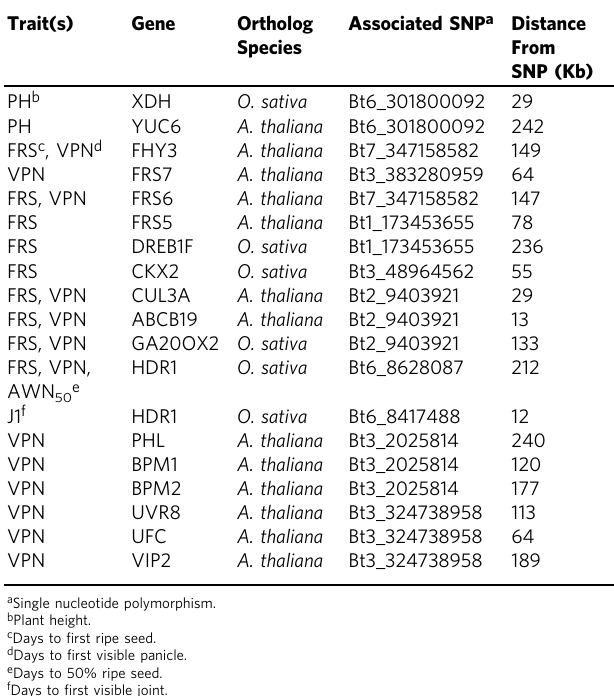
Table 3 Candidate genes within 250 kbp of SNP identi fi ed by GWAS, with two ortholog species Arabidopsis thaliana and Oryza sativa